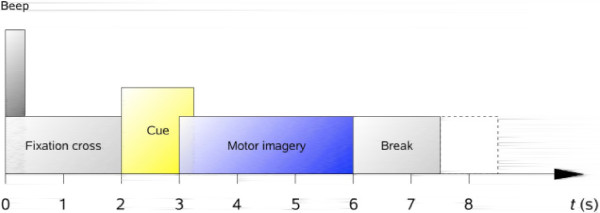
Timing scheme of the experiment.